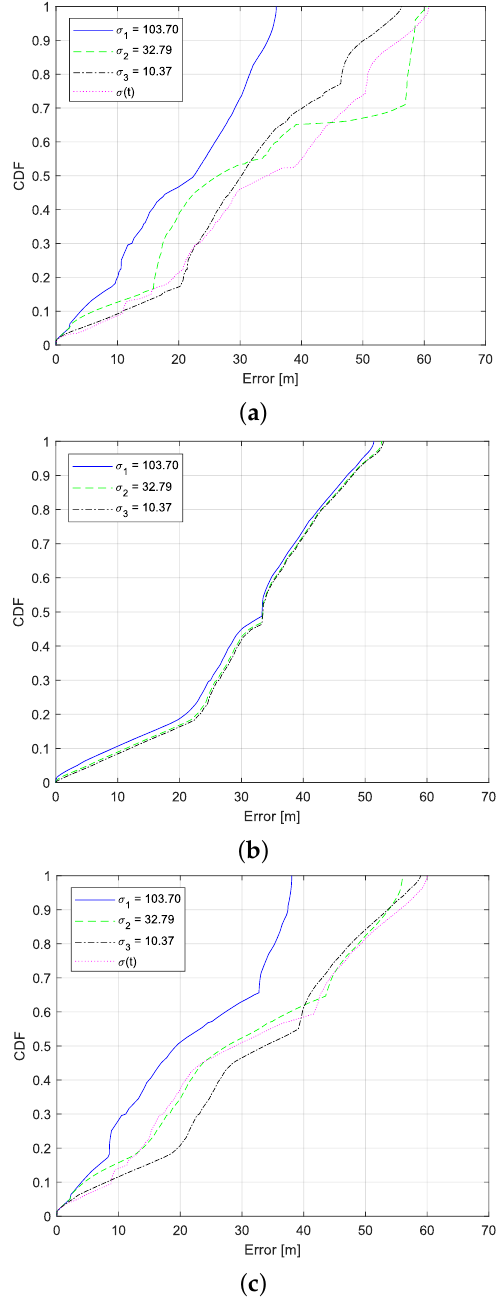
Figure 4. CDF of the location estimation errors for different filtering approaches ( a ) EKF DS, ( b ) KF DS and ToA, and ( c ) EKF DS and KF ToA, while using various standard deviation values σ i